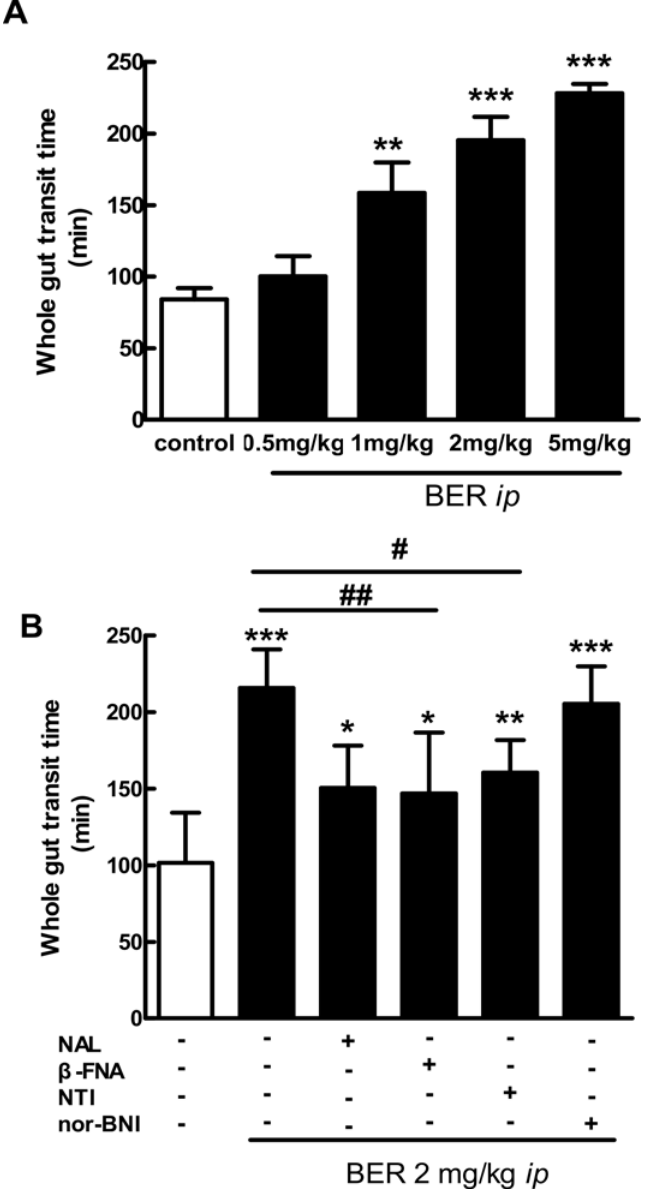
Fig 1. Effect of berberine (BER) alone or in presence of opioid antagonists on whole gut transit time in mice. Data are mean ± SE ( n = 6 – 10). A: I . p . berberine (0.5, 1, 2 and 5 mg/kg) prolonged the whole gut transit time in a dose-dependent manner. ** P < 0.01, *** P < 0.001 vs . control. B: I . p . naloxone (NAL, 1 mg/kg), β -funaltrexamine ( β -FNA,1 mg/kg) and naltrindole (NTI, 1 mg/kg), but not nor-binaltorphimine (nor- BNI,10 mg/kg) blocked the effects of berberine(BER, 2 mg/kg, i . p .) on the whole gut transit time. * P < 0.05, ** P < 0.01 and *** P < 0.001, vs . control; # P < 0.05 and ## P < 0.01, berberine vs . berberine +